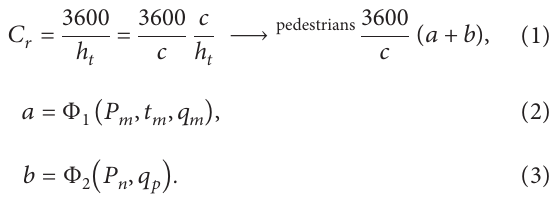
Figure 2 is the block diagram of the PV-RTC